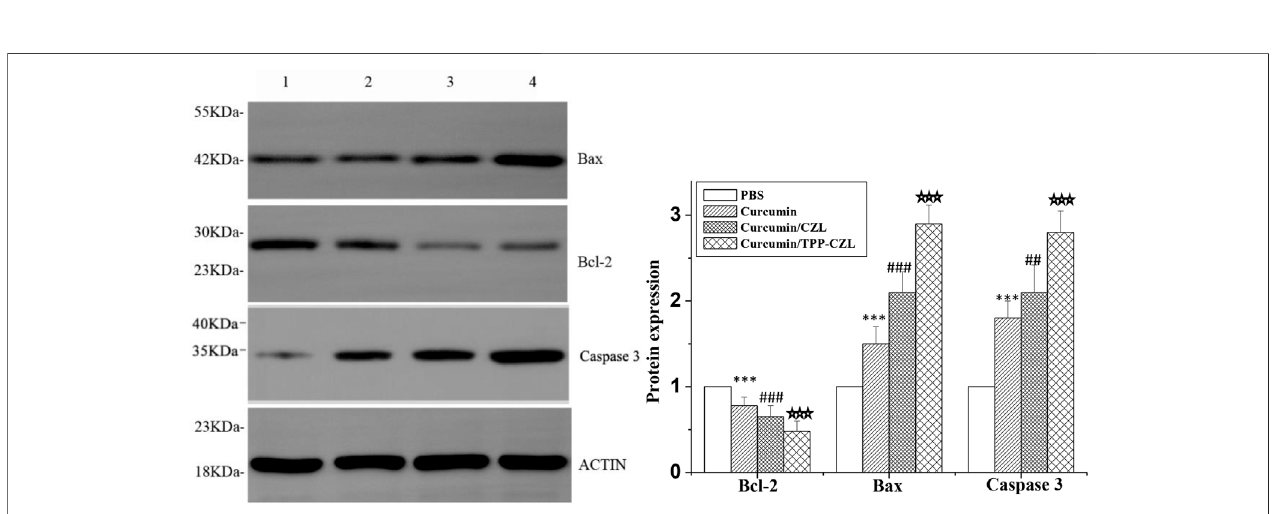
FIGURE 7 | Comparison of protein expression of Bcl-2, Bax, and caspase 3.1. PBS, 2. curcumin, 3. curcumin/CZL, 4. curcumin/TPP-CZL. * p < 0.05, ** p < 0.01, *** p < 0.001comparedwithPBSgroup;# p < 0.05, ## p < 0.01,### p < 0.001compared withcurcumingroup; p < 0.05, p < 0.01, p < 0.001compared withCZLgroup.